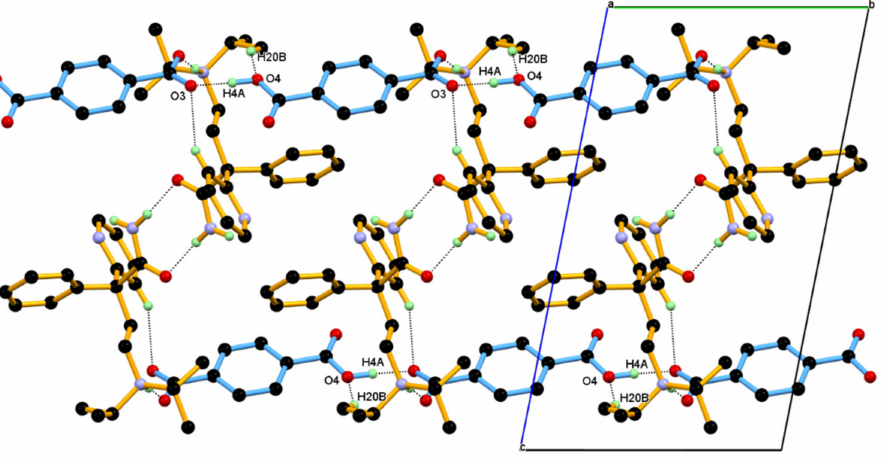
Figure 4. Linking of neighboring unit translated dimeric units along the b -axis through O4–H4 ··· O3 ¯ and C20–H20B ··· O4 hydrogen bonding interaction to form a ladder structure along the b -axis. In this packing, the protonated DPA dimer is held between the 1D chain of the TA